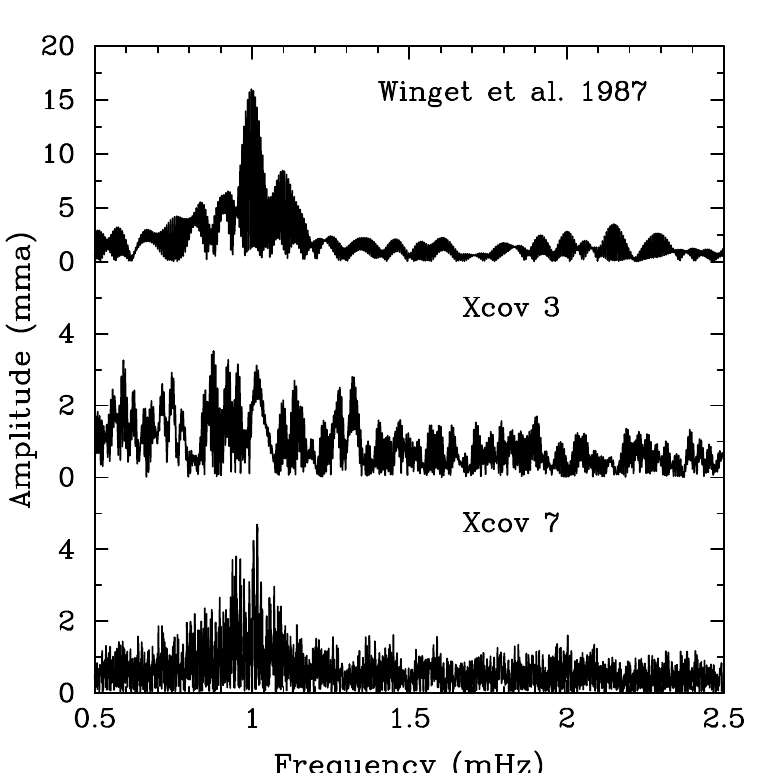
Fig. 2. Fourier amplitude spectra of all available measurements of PG 1115+158. The time scales of the variations are always similar, but individual frequencies do not agree even considering aliasing. Note the larger amplitude scale of the uppermost